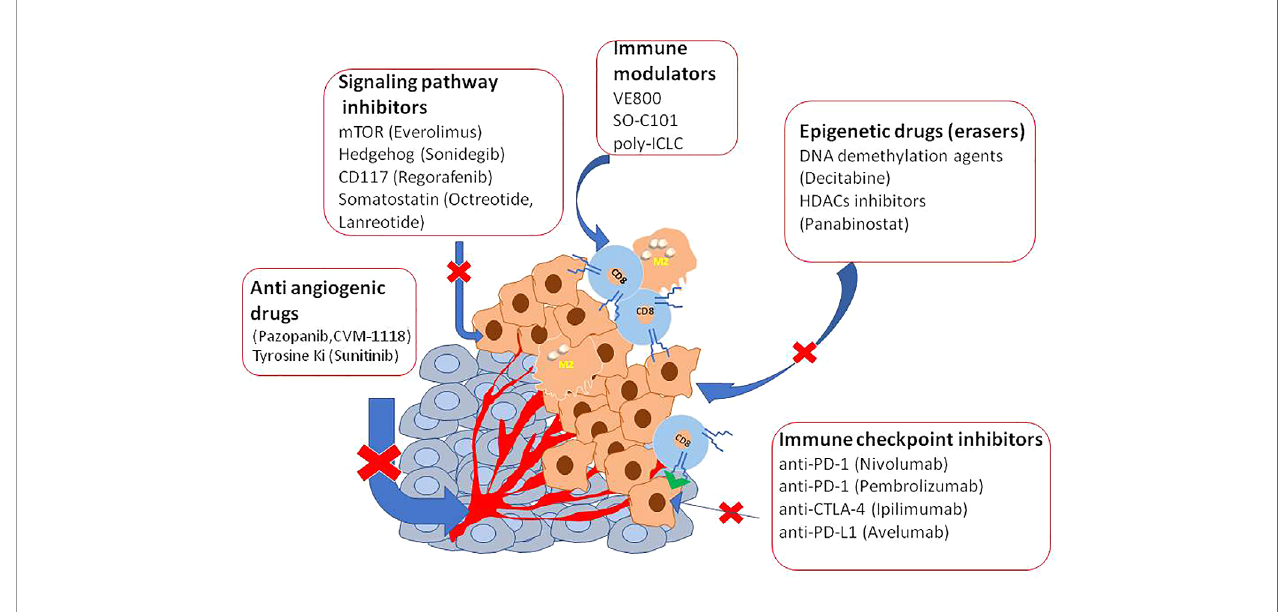
FIGURE 1 | A list of epigenetic agents useful in the therapy of NETs.